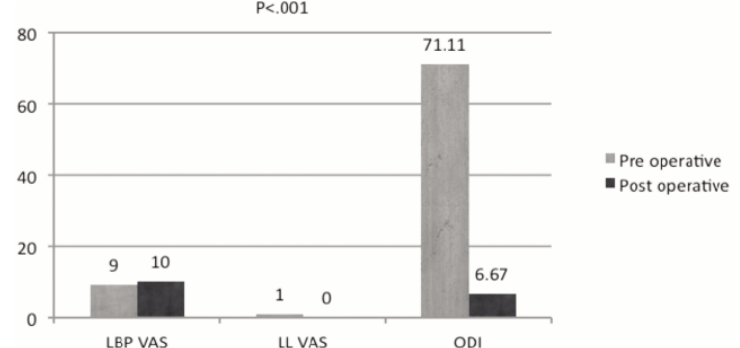
Bar diagram showing outcome parameters, Low back pain VAS, Limb VAS and ODI score. Fig. 1: